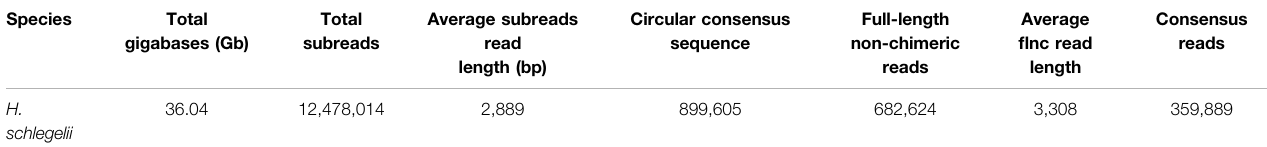
TABLE 1 | Description of Iso-Seq from the gonads of H. schlegelii by PacBio Sequel platform. Species Total gigabases